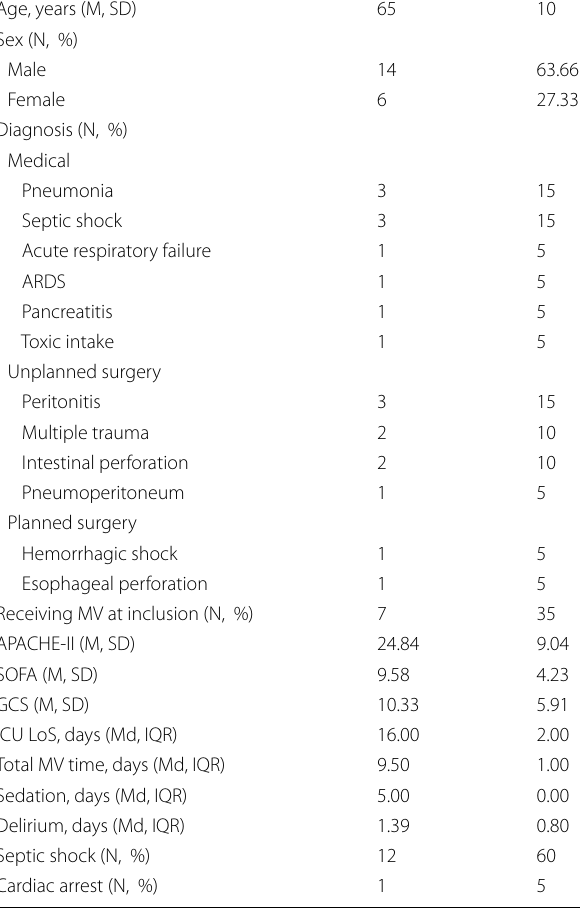
Table 1 Clinical and sociodemographic characteristics of critically ill patients undergoing early neurocognitive intervention (n =